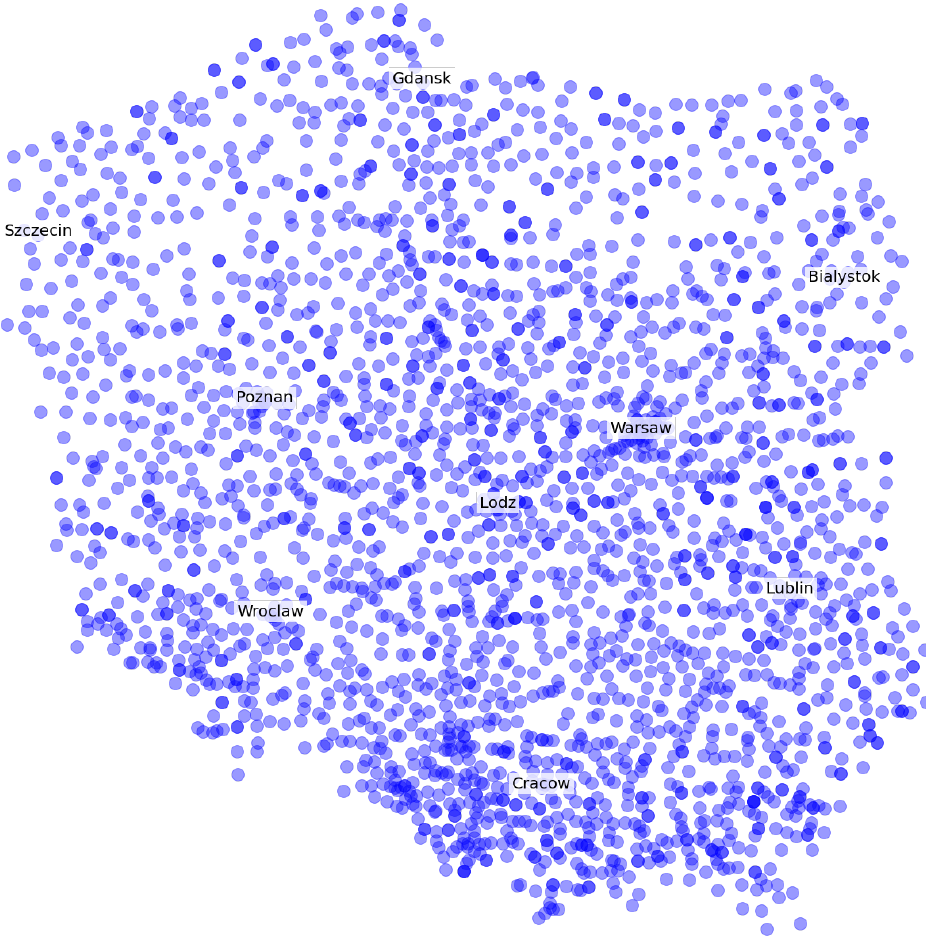
Figure 2. Location of the centroid of traffic analysis zones in the model of the transport system.